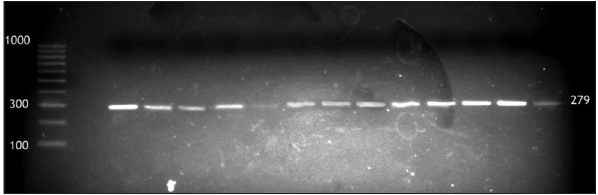
Figure-1: Electropherotic profile of Staphylococcus aureus isolates positive nuc gene 279 bp, DNA marker 100 bp (Jena Bioscience).